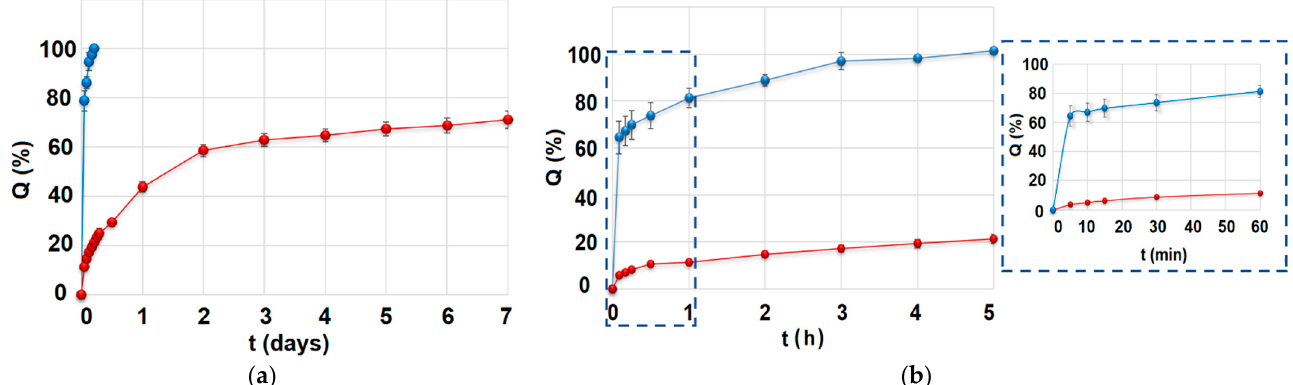
Figure 4. ( a ) The overall drug release profile of MCM-DOX (blue) and pellets (red) samples; ( b ) First 5 h of drug release for both MCM-DOX (blue) and pellets (red) samples with insert related to the first 60 min of drug release.